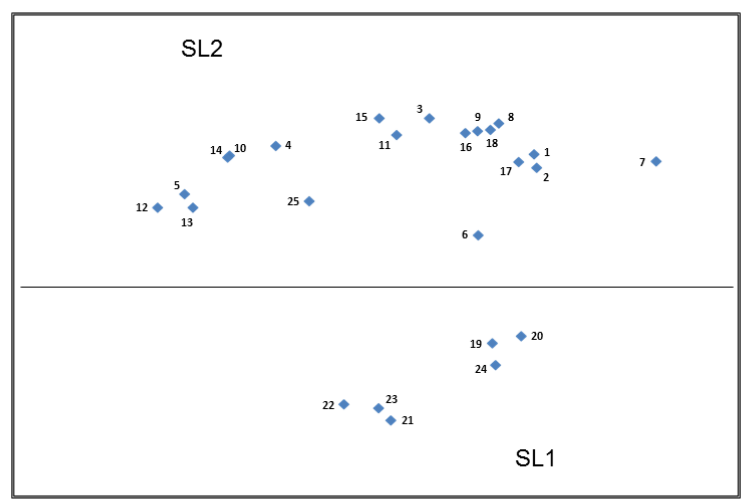
Figure 5. MSA Top Plot—Slovenia (SL). See Table 2 for the claims associated with the stimuli card